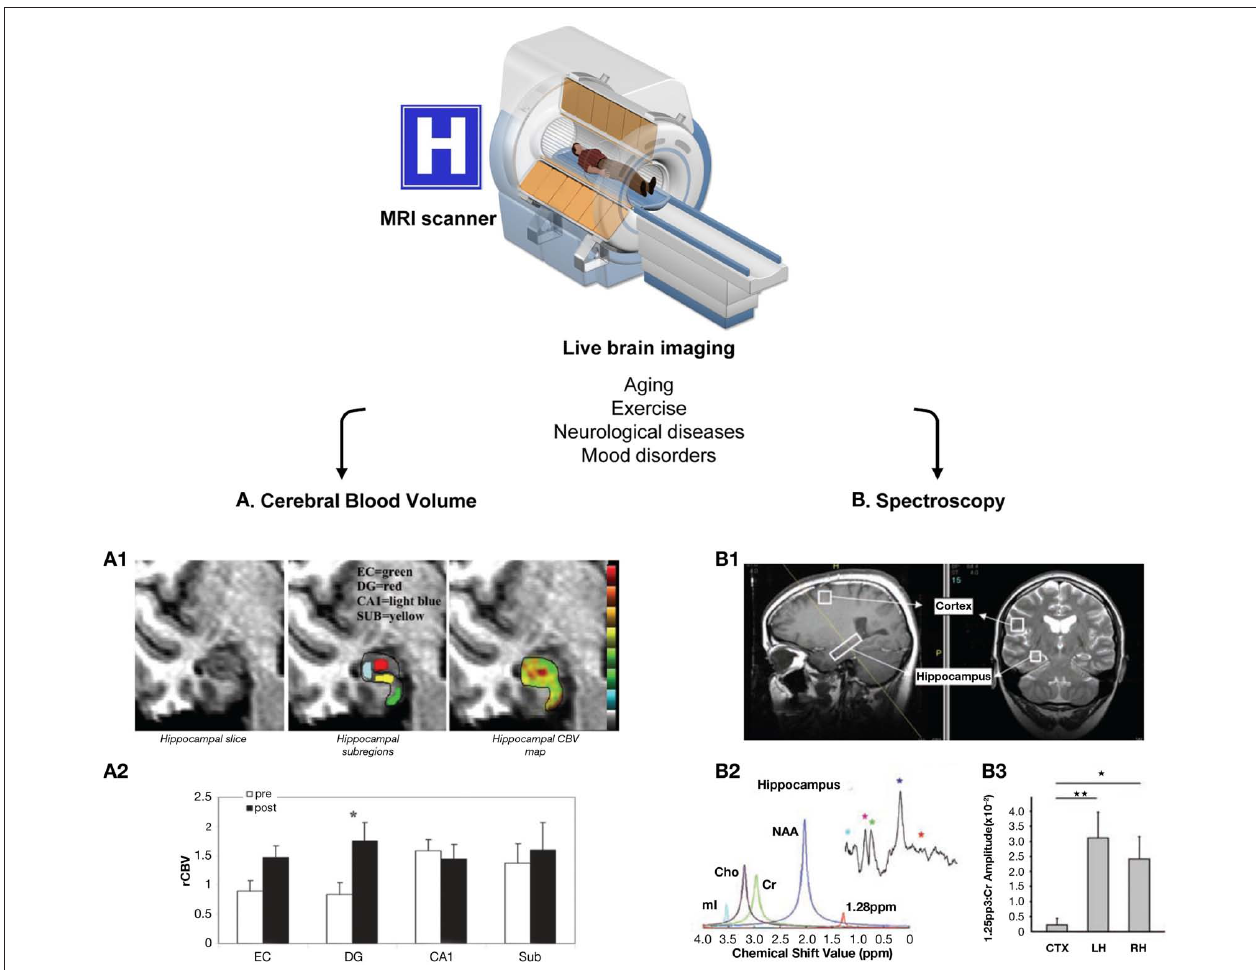
CVB only in the DG (asterisk). (B) Spectroscopy. A lipidic metabolite resonating at 1.28 ppm was identified as a marker of rodent NPCs. (B1) Positioning of the voxel of interest in the cortex and the hippocampus of a healthy person. (B2) Spectroscopic analysis of the metabolite content in the hippocampal voxel using SVD and FFT (small upper insert). Identified metabolites are myoInositol (mI, light blue), choline (Cho, purple), creatine (green), N -acetylaspartate (NAA, dark blue), and the 1.28 ppm metabolite (red). (B3) Quantification of the abundance of the 1.28 ppm metabolite in the cortical (CTX) and hippocampal voxels (LH and RH for left and right hippocampus, respectively), normalized over the amplitude of the creatine peak. The hippocampi had much higher content of the 1.28 ppm metabolite than the cortex. The MRI cutaway is printed from permission from the National High Magnetic Field Lab website (http://www.magnet.fsu.edu/ education /tutorials/magnetacademy/mri/). Figures (A1–A2) are reprinted by permission from Pereira et al. (2007), copyright 2007, National Academy of Sciences, U.S.A. Figures (B1–B3) are from Manganas et al. (2007) and are reprinted with permission from